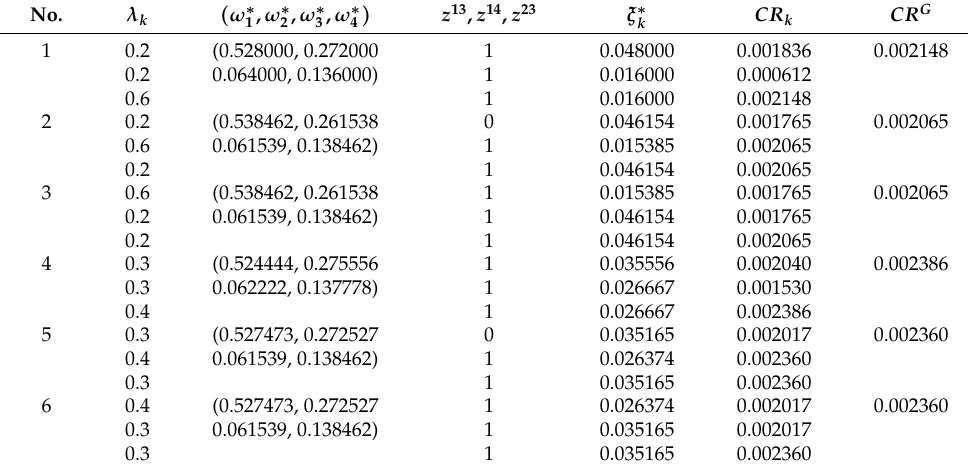
Table 9. Result of Example 2 for MD-2.